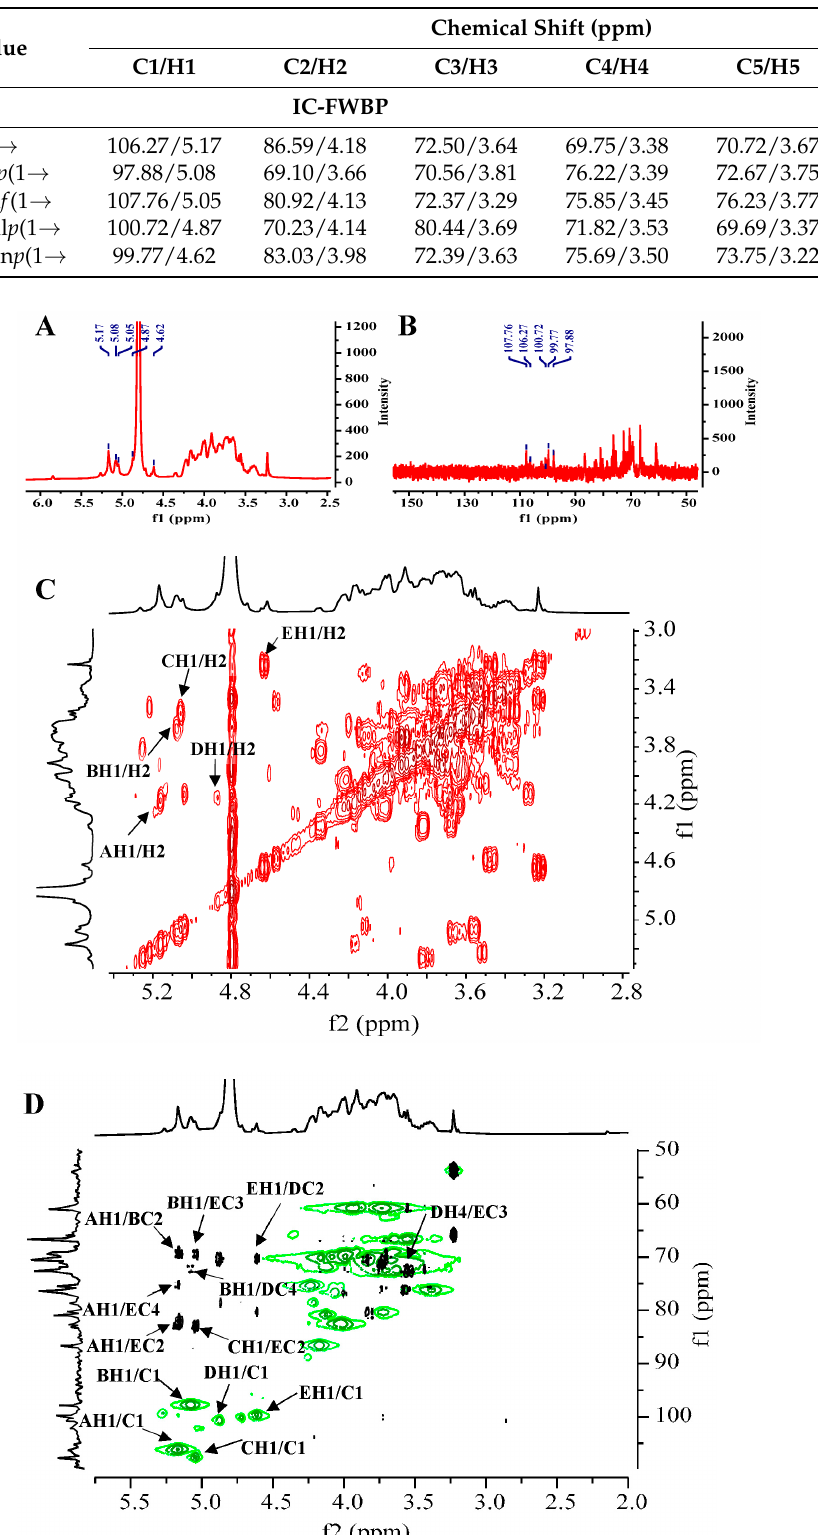
Table 3. Assignments of 13 C NMR and 1 H NMR chemical shifts of the IC-FWBP.